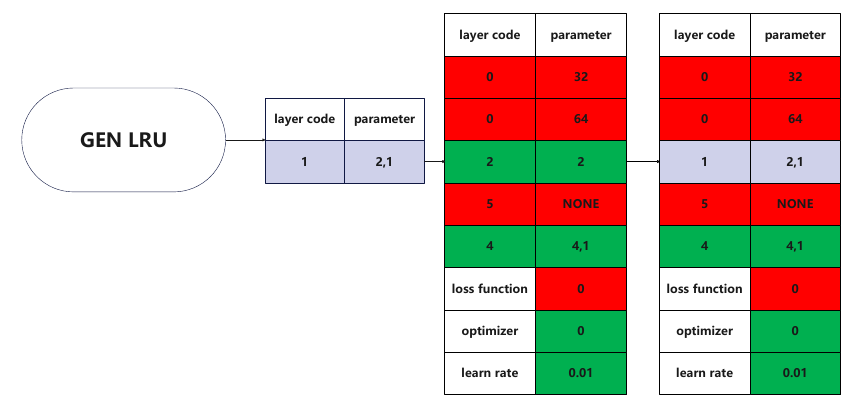
Figure 4. GEN LRU.